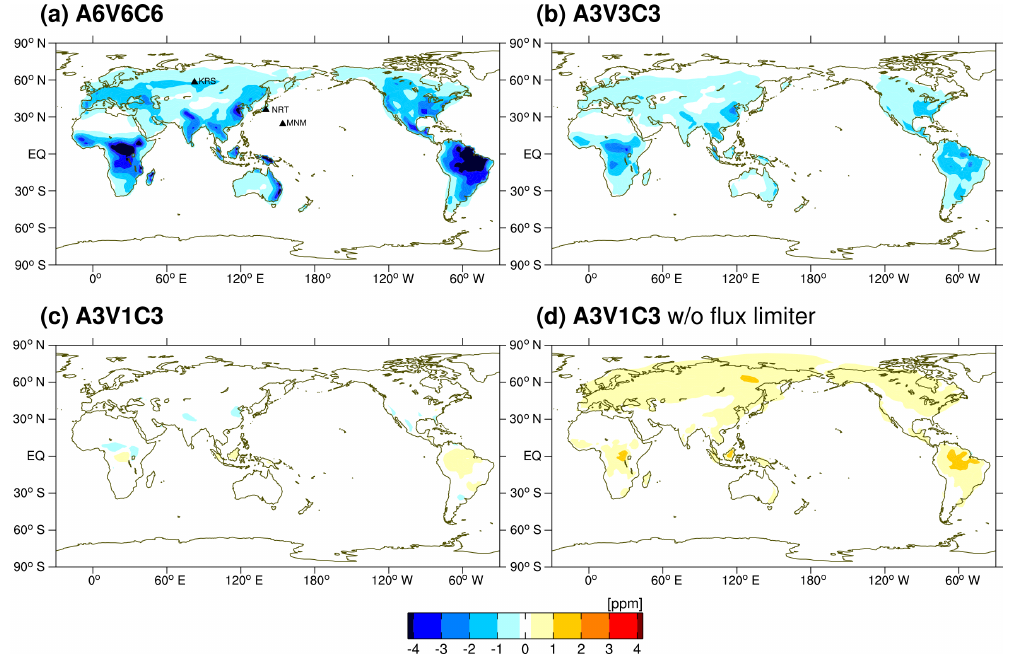
Figure 3. Annual mean difference of CO 2 concentration at the surface model layer between the offline and online models (offline minus online) for each sensitivity test: A6V6C6 (a) , A3V3C3 (b) , A3V1C3 (c) , and A3V1C3 without the flux limiter (d) . White colored areas signify absolute values less than 0.2ppm. The geographical locations of Minamitorishima (MNM), Karasevoe (KRS), and Narita (NRT) are also indicated in (a) . Table 3. Temporal correlation coefficients of simulated residual CO 2 concentrations (see the text for details) with the observations at Mi- namitorishima, Karasevoe, and 8–10km altitude over Narita for the online and offline (A6V6C6 and A3V1C3) simulations. The results of A3V1C3 without the flux limiter and the online model nudged by JRA-55 are also shown. Site Online A6V6C6 A3V1C3 A3V1C3 Online w/o flux limiter nudged by JRA-55 Minamitorishima 0.577 0.572 0.575 0.573 0.587 Karasevoe 0.610 0.579